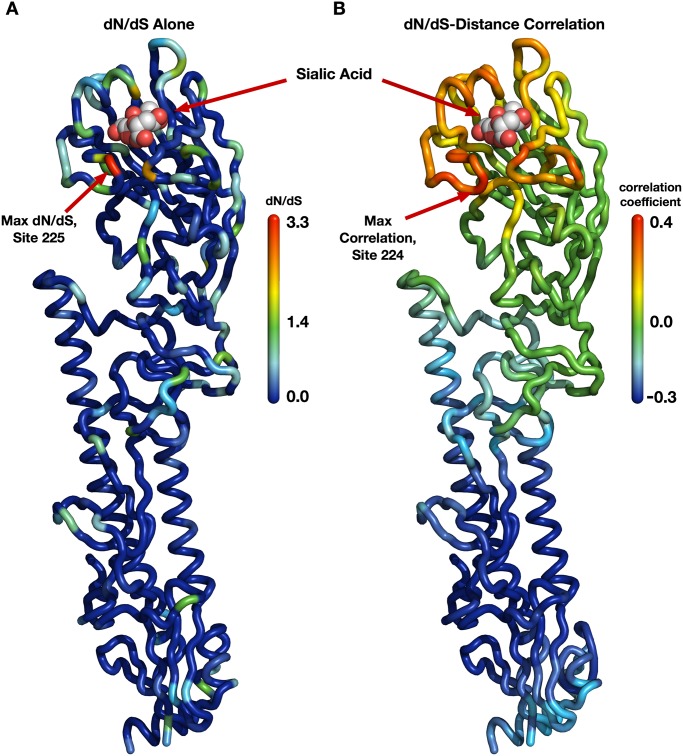
Evolutionary-rate variation along the hemagglutinin structure.(A) Each site in the protein structure is colored according to its evolutionary rate dN/dS. Hot colors represent high dN/dS (positive selection) while cool colors represent low dN/dS (purifying selection). (B) Each site in the protein structure is colored according to the dN/dS–distance correlation obtained when distances are calculated relative to that site. Hot colors represent positive correlations while cool colors represent negative correlations. Thus, distances from sites that are redder are better positive predictors of the evolutionary rates in the protein than are distances from bluer sites; distances from blue sites are actually anti-correlated with evolutionary rate. Distances from sites that are colored green have essentially no predictive ability.